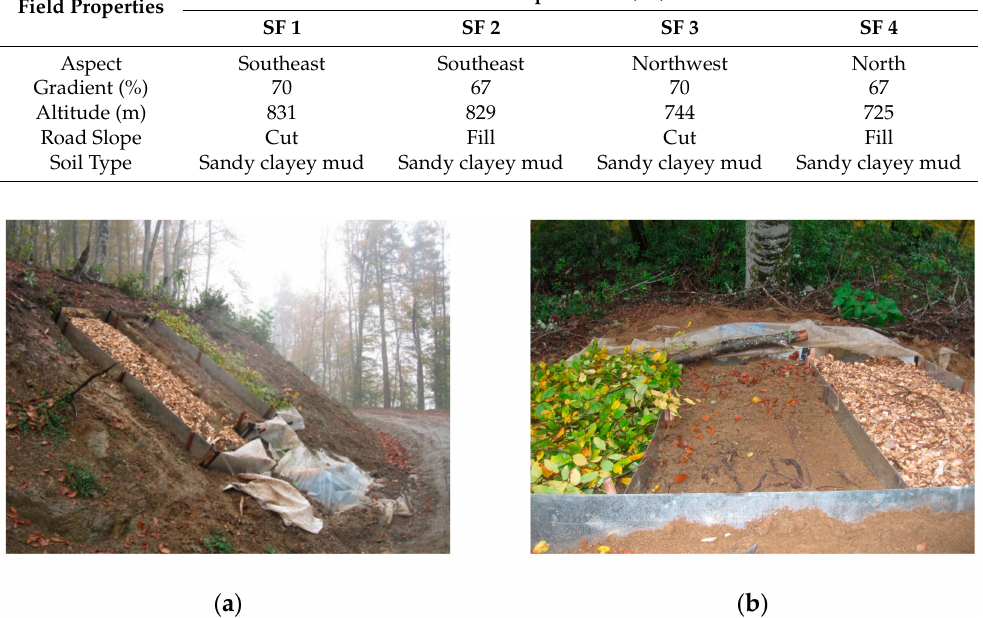
Figure 2. Establishment of runoff plots on road slopes: ( a ) Cutslopes (left—wood chips; center—control; right—slash); ( b ) fillslopes (left—slash; center—control; right—wood